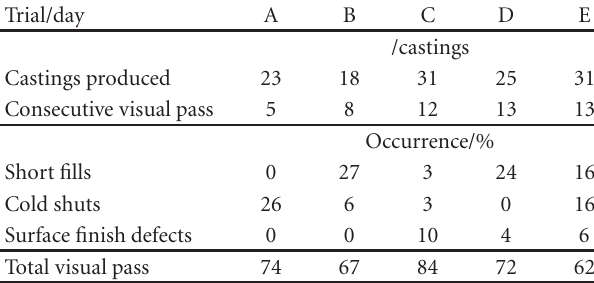
Table 2: Results of the aluminum A356 brake caliper casting runs on di ff erent days with the CSIR-RCS and